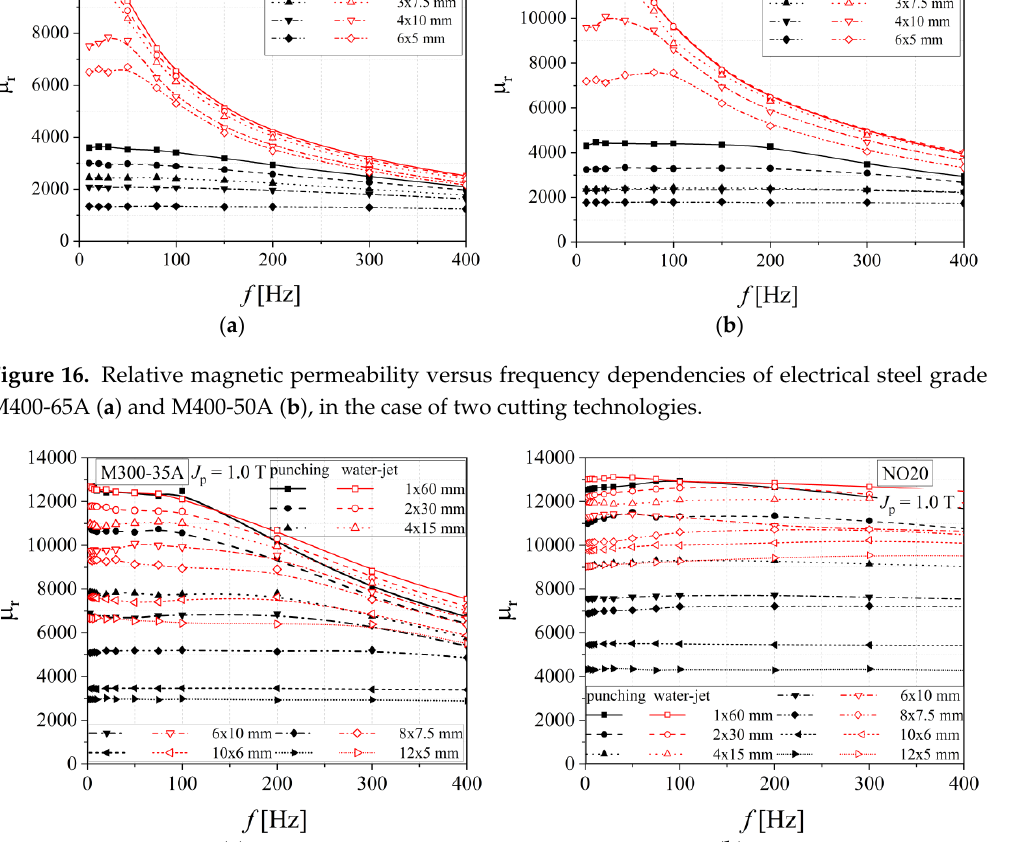
Figure 17. Relative magnetic permeability versus frequency dependencies of electrical steel grade